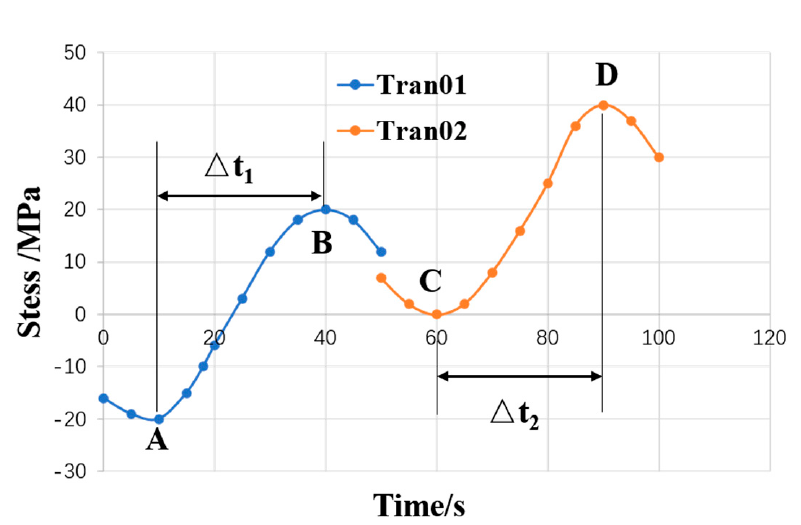
Figure 2. Diagram of the simplified average strain method.